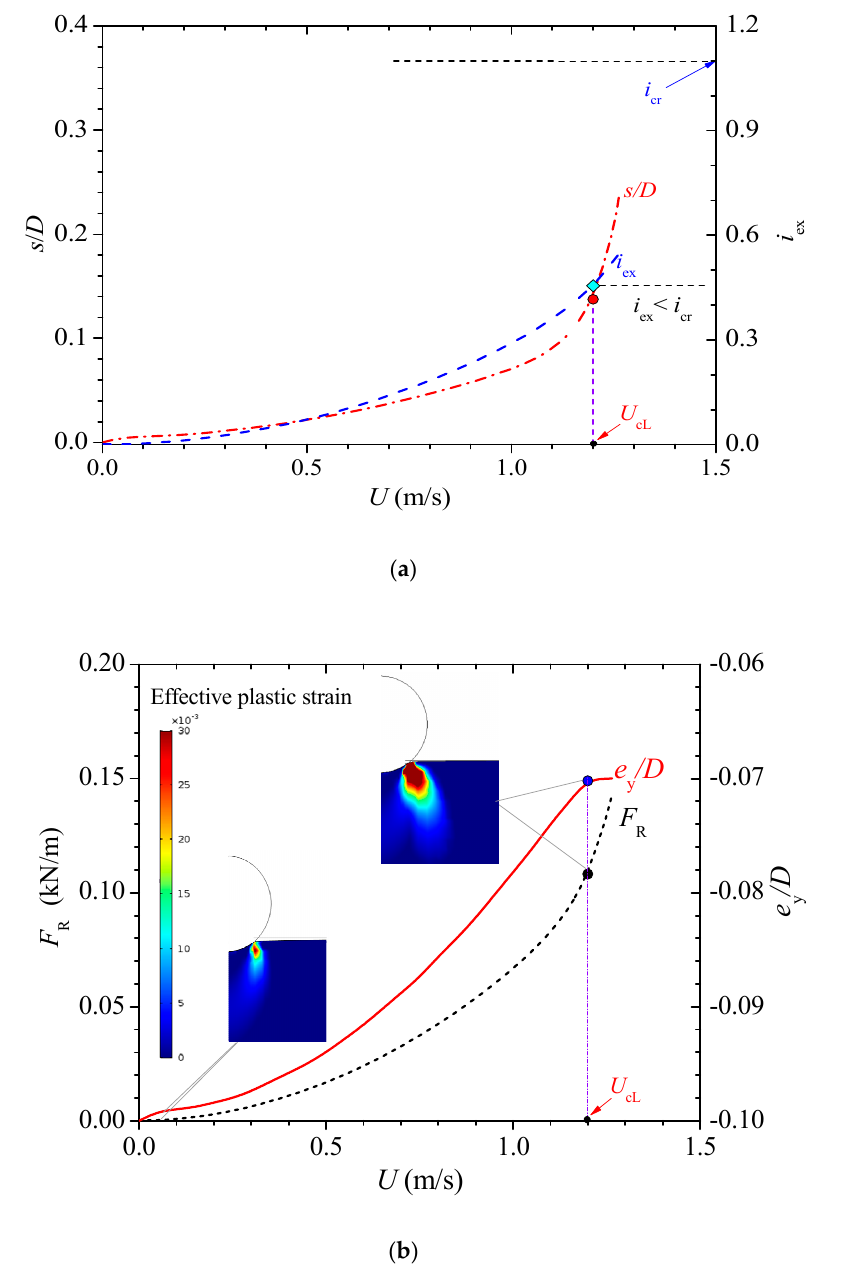
Figure 9. Competition between tunnel erosion and lateral instability: Developments of ( a ) the pipe lateral displacement ( s / D ) and the maximum upward hydraulic gradient ( i ex ) and ( b ) the lateral soil resistance ( F R ) and the corresponding pipe embedment ( e y /D ) with increasing flow velocity ( U ).